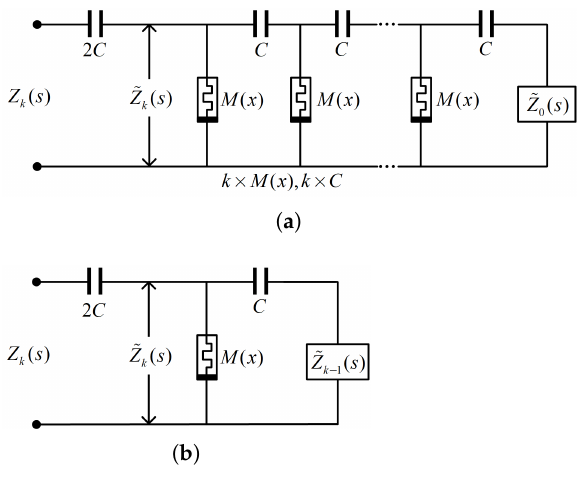
Figure 1. Half-order chain-type fracmemristor circuit: ( a ) circuit configuration; ( b ) iterating